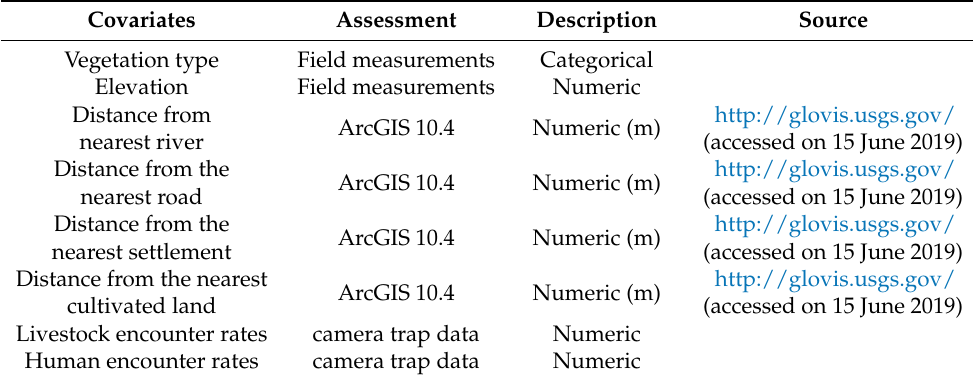
Table 1. Sources of variables used for model